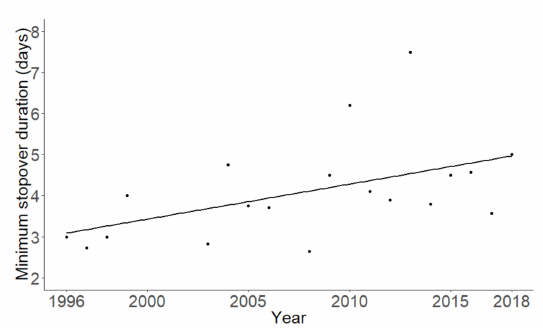
Figure 2. The average minimum stopover duration at the study site of Pied Flycatchers over the years.